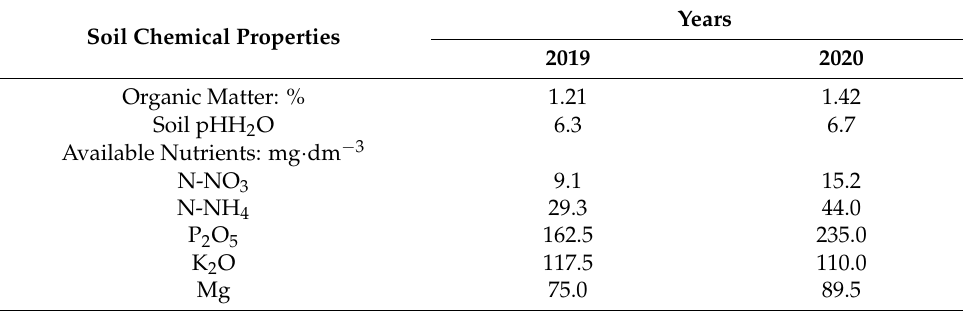
Table 1. Soil chemical properties at the experimental site.